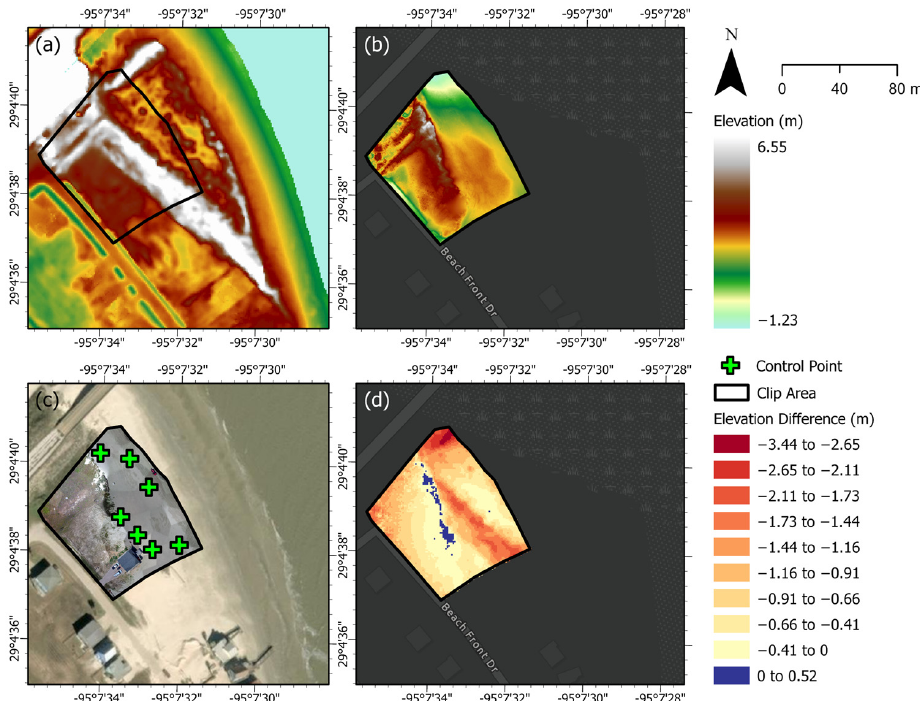
Figure 15. Follett’s Site 1 comparison of 2022 UAV data and 2018/2019 data. Spatial Reference: NAD 1983 UTM Zone 15n. ( a ) 2018/2019 NOAA’s Post Hurricane Harvey elevation model with survey clipping boundary; ( b ) May 2022 digital elevation model; ( c ) May 2022 orthophoto with a World Imagery Maxar base map; ( d ) Elevation difference map with erosion represented as yellow through red, and deposition represented by blue.